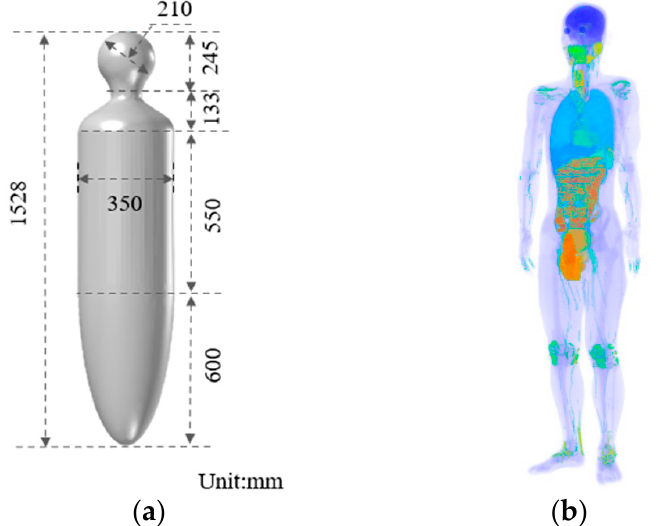
Figure 3. Human-body model. ( a ) Homogeneous axial-symmetric human model. ( b ) Japanese adult male model TARO.